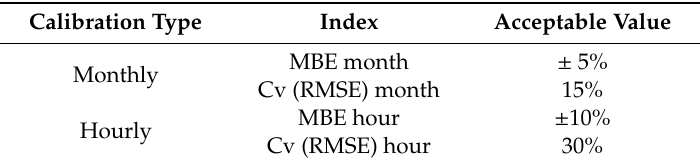
Table 9. Acceptable range of ASHRAE Guideline 14.